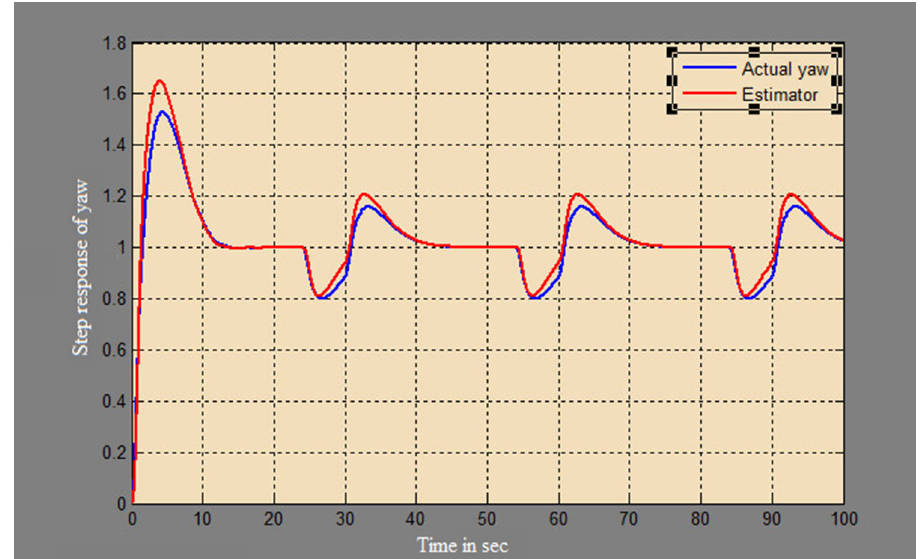
Figure 12. Estimation of yaw for a step input with a disturbance with Luenberger